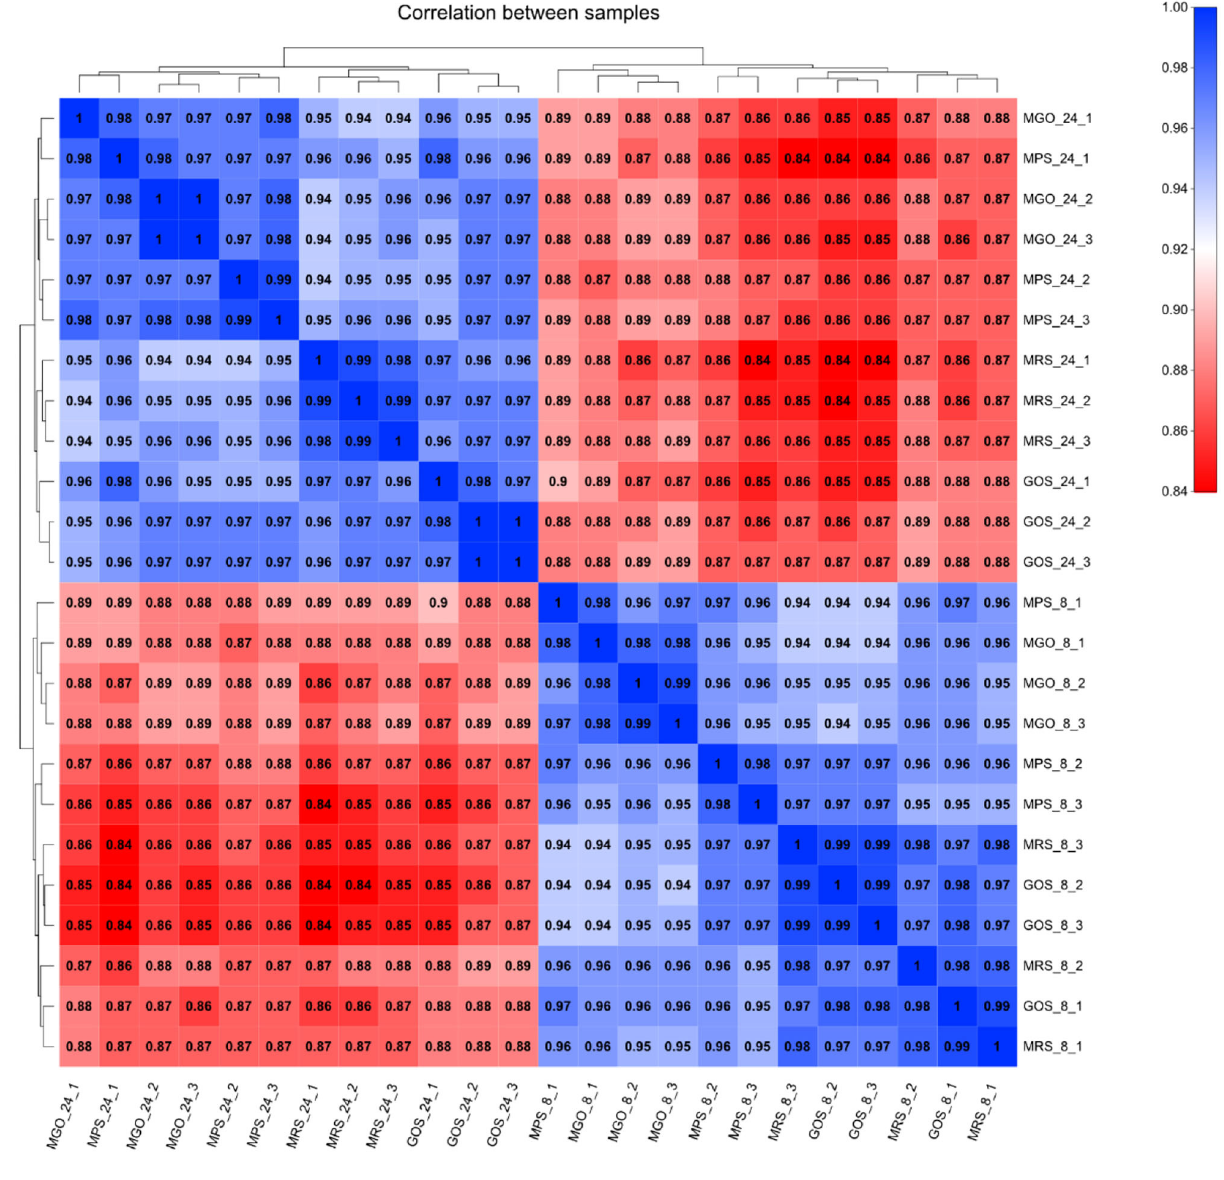
FIGURE 2 | Clustering analysis of differentially expressed genes with different